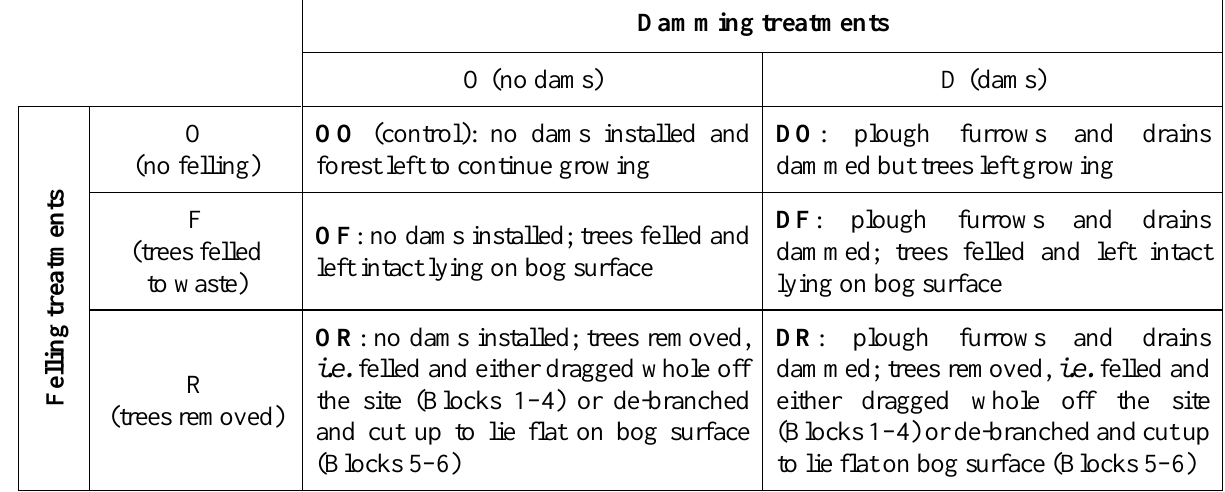
Table 2. Experimental treatments.